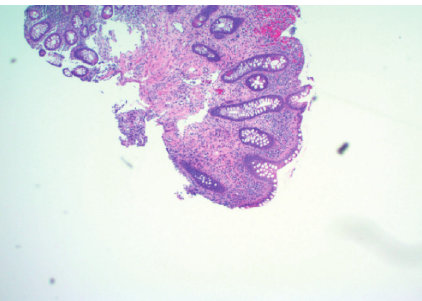
Figure 4: H&E staining of the colonic mucosa (poststeroid treatment) showing focal active chronic colitis without any evi- dence of dysplasia, metaplasia, or noncaseating